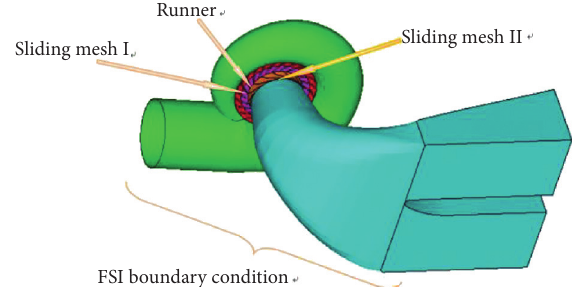
Figure 6: Boundary condition